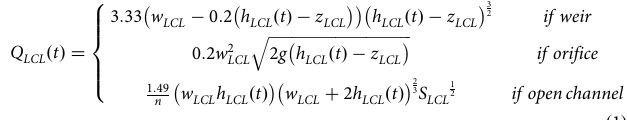
(Supplementary Table 1). Next, assessing coastal fl ood exposure for the under- ground portions of the system, we obtain water surface elevation time series data for each lowest critical location (LCL 57 ) in the system. For each LCL (Supple- mentary Table 2), given its estimated elevation (provided by publicly available data 58 ) its dimensions, and hydraulic characteristics, we calculate in fl ow for each time step provided using standard hydraulics equations 59